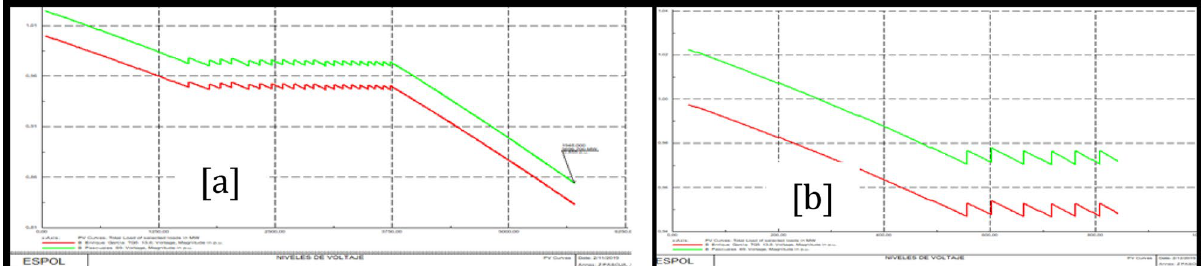
Figure 17. Stability PV before load model ( a ) and PV after load model ( b ) Pascuales 69 kV bus.